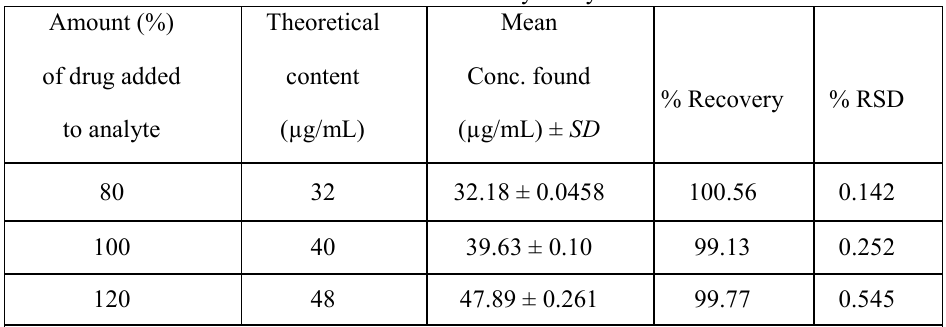
Table 3. Accuracy